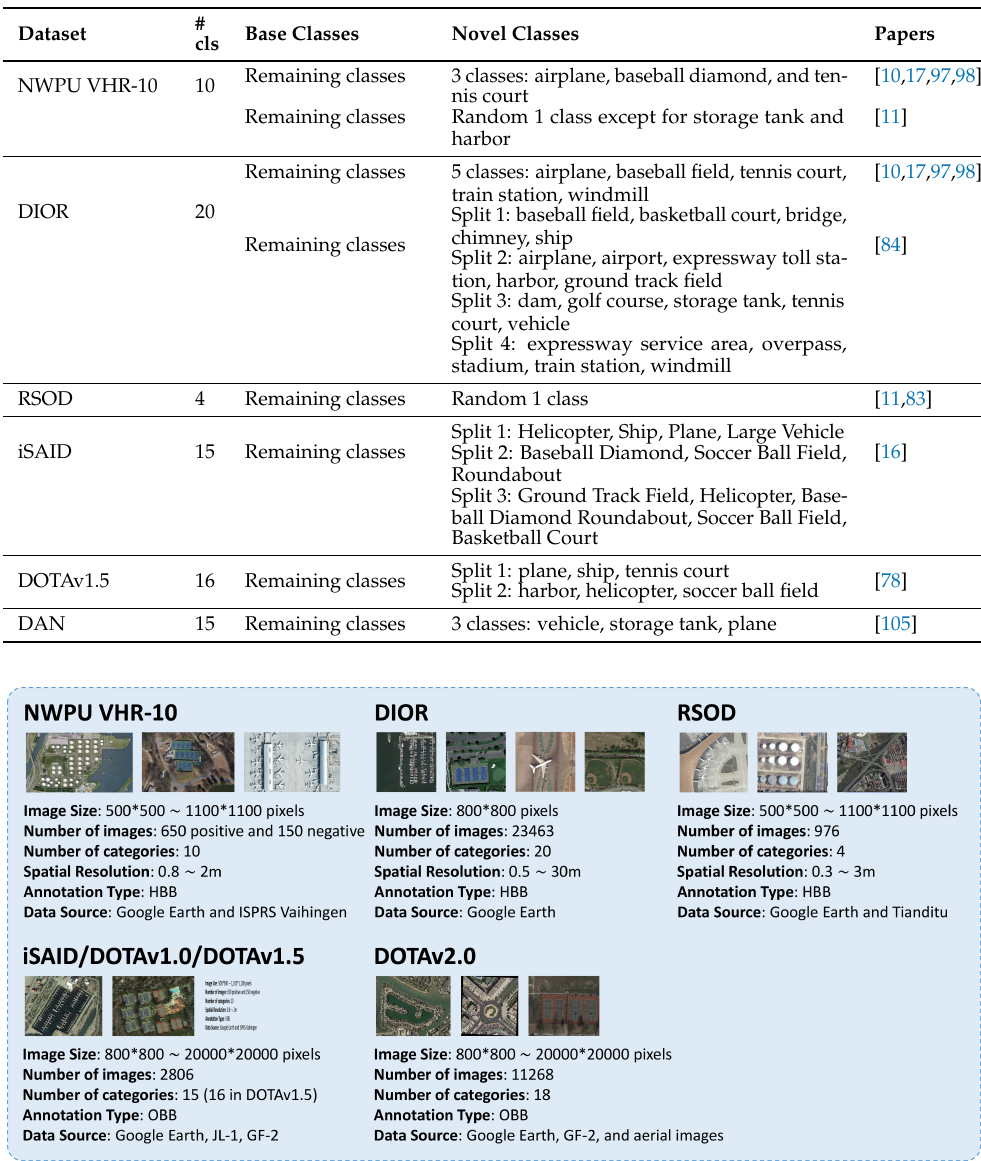
Figure 16. Detailed information of RS object detection